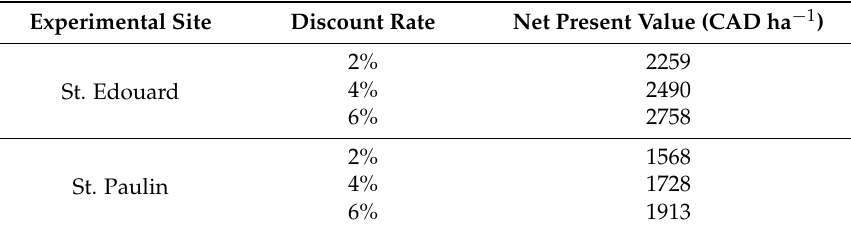
Table 2. Financial benefits of carbon (C) sequestration in tree-based intercropping systems 10 years after tree establishment for St. Edouard and St. Paulin experimental sites, Quebec, QC,